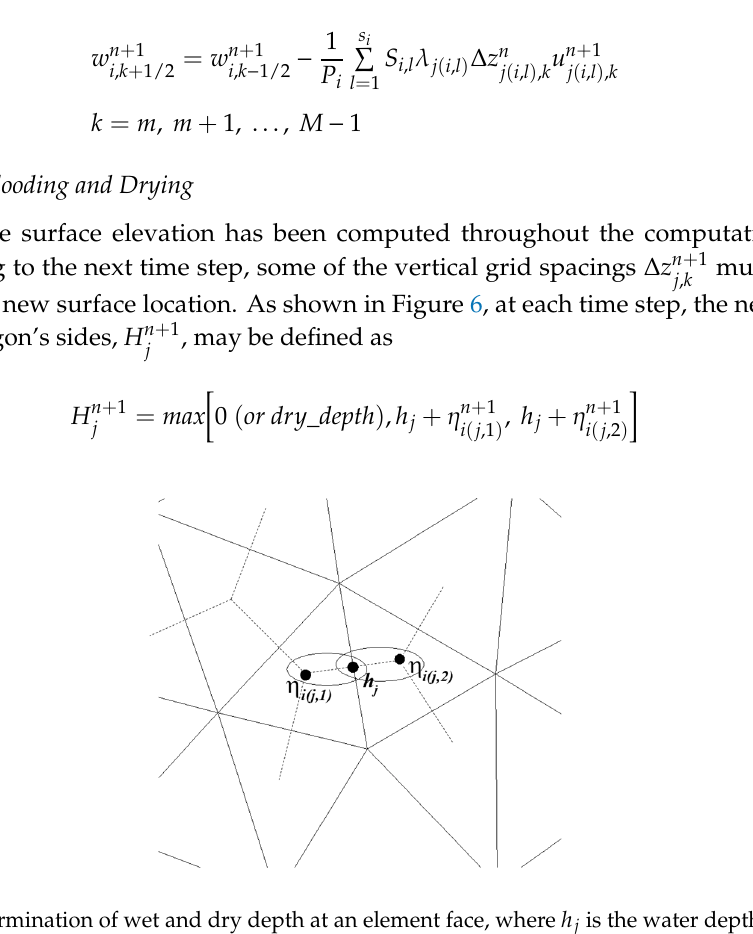
Figure 6. Determination of wet and dry depth at an element face, where h j is the water depth at the j th side; η i ( i .1 ) is the water surface elevation at the i th element; and η i ( i .2 ) is the water surface elevation at the neighboring element which shares the j th side.